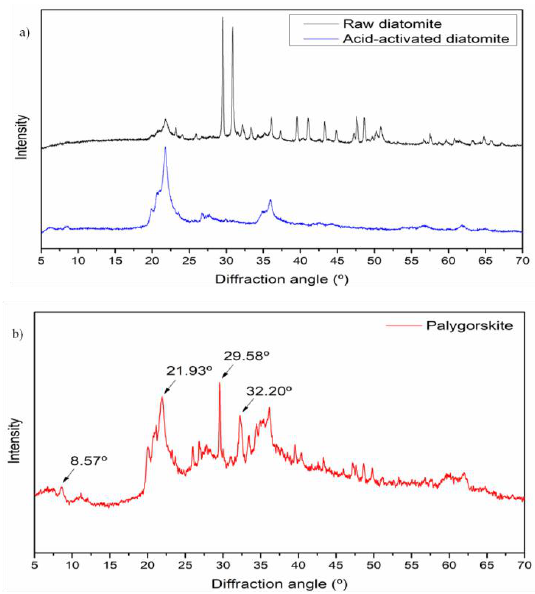
Figure 1. Analyses of XRD for ( a ) raw and purified diatomite; ( b ) palygorskite.